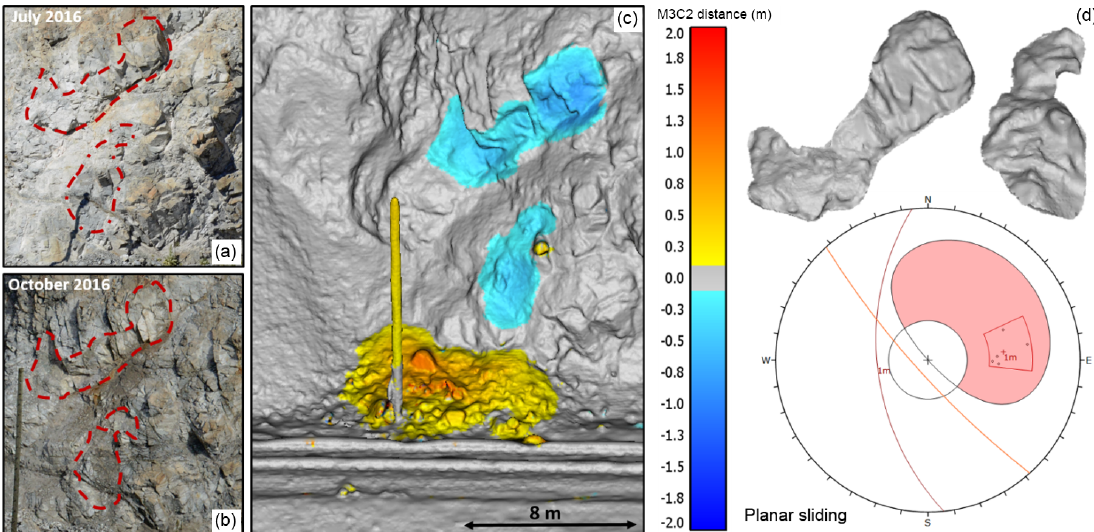
Figure 7. Site E. Schematic overview of the 8m 3 planar sliding event detected at the White Canyon West site between July and October 2016. The event involved the failure of two distinct sections of the jointed source rock mass, with the upper (6m 3 ) and lower (2m 3 ) failures releas- ing from 10 and 6m above track level respectively. Site photos (a, b) of the source zone pre- and post-failure are shown. Change detection results of the event are shown (c) with cool colours indicating material loss and warm colours indicating material accumulation. Interpretation of the post-fall imagery indicates that the lower failure was inside the slide path of the upper rockfall event. It is our interpretation that these events likely occurred simultaneously, with the lower failure occurring as a result of impact from the upper failure. Change detection results indicate that the bulk of the material from the two events was retained by the track-side ditch. The rockfall hull of the events, extracted from the pre- and post-failure meshes is shown (d) , as well as a stereonet representation of the planar sliding failure mode for the upper, larger